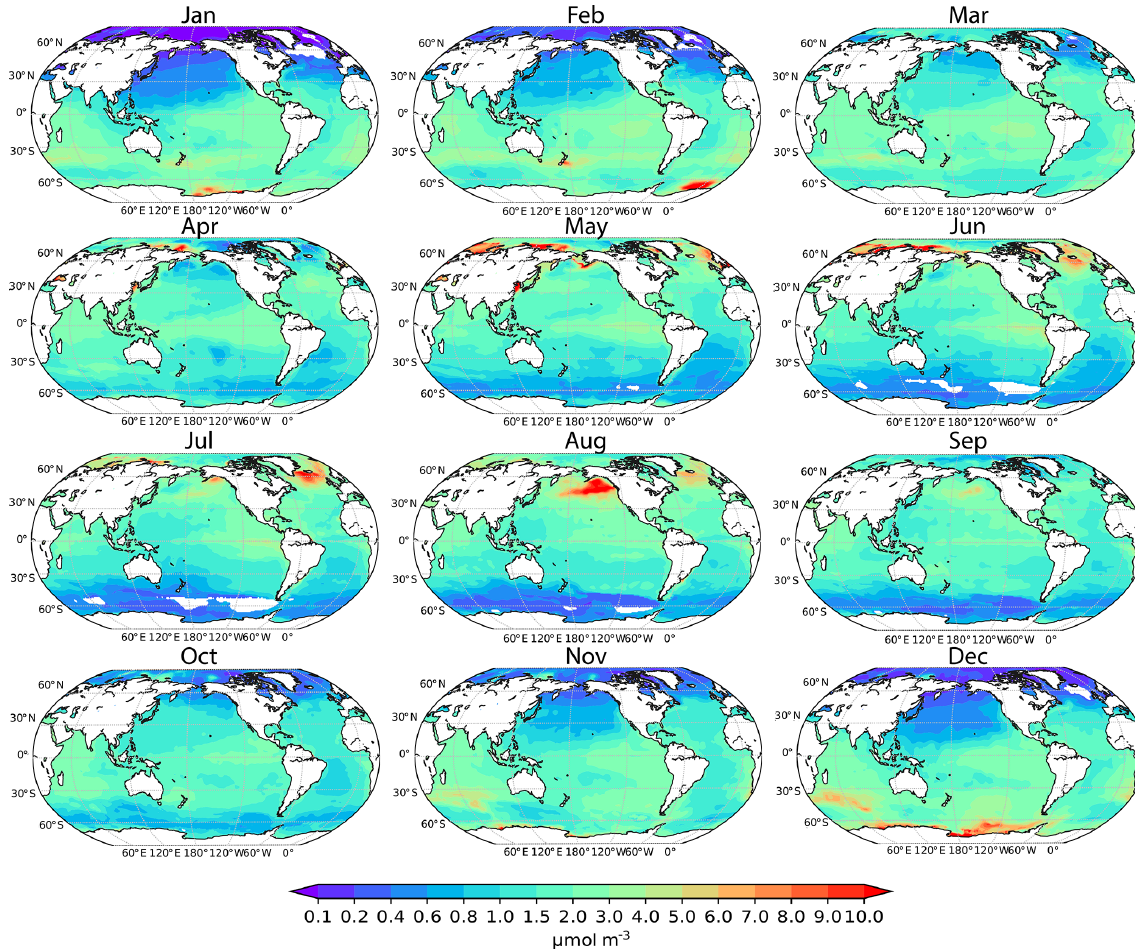
Figure 5. Monthly DMS concentration (nM) estimated based on artificial neural